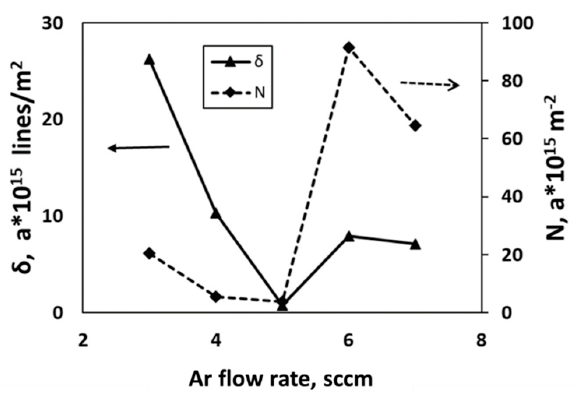
Figure 7. Relation between dislocation density ( δ ) and crystallites per unit area (N) for different Ar gas flow rates of as-deposited WS 2 films .